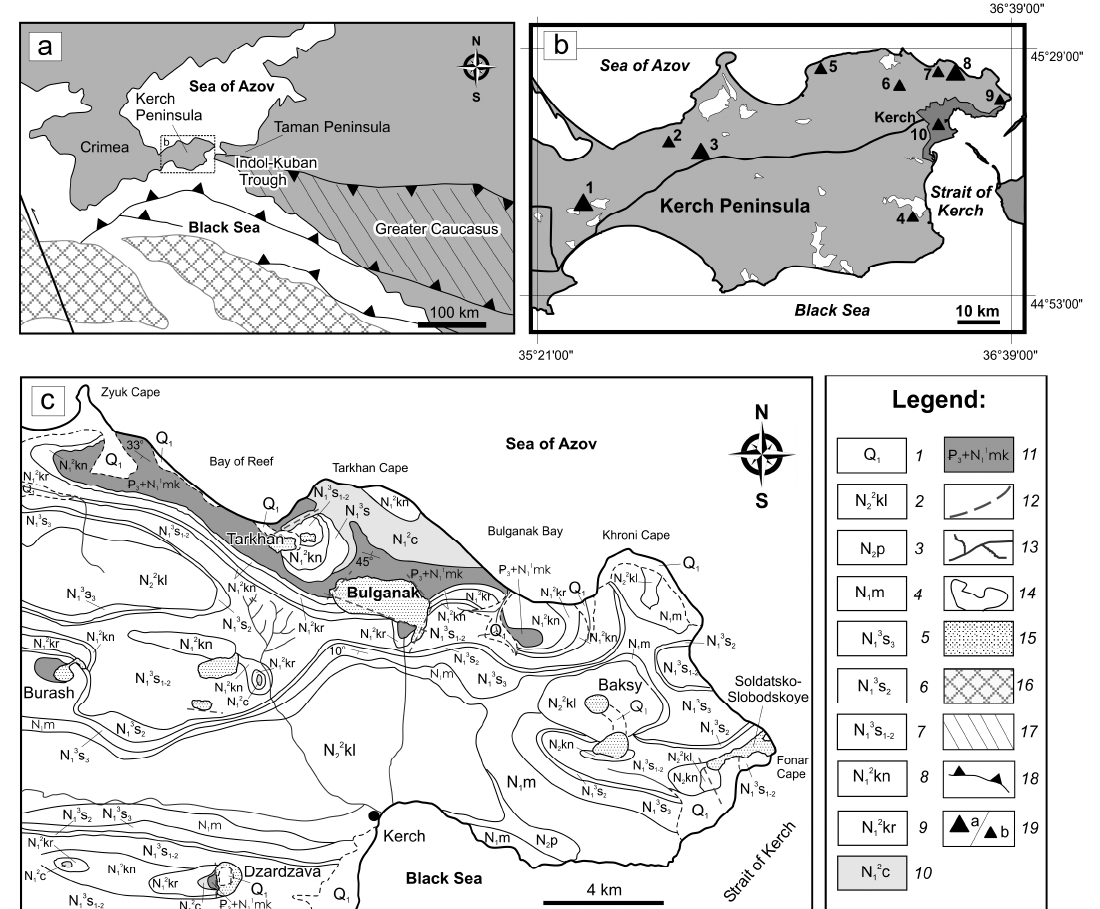
Figure 1. ( a ) Sketch map of the northeastern Black Sea region. Modified after [2]; ( b ) Location map of sampled mud volcanoes in the Kerch-Taman MV province. Modified after [3]. Grey colour–onshore area; white colour–offshore area. Mud volcanoes: Vladislavovsky (1), Nasyr (2), Korolevsky (3), Tobichek (4), Suyurtash (5), Burash (6), Big Tarkhan (7), Bulganak field (8), Eny–Kale (9), Soldatsko–Slobodsky (10); ( c ) Detailed geological map showing locations of mud volcanoes, geological structures and their sedimentary stratigraphy in the northeastern Kerch Peninsula. Modified after [59]. 1—Lower Quaternary sand, clay silt, and clay (Q 1 ); 2—Middle Pliocene sand, clay, and iron ore (Kuyalnik stage N 22 kl); 3—Lower Pliocene (Pontic stage N 2 p) shelly limestone, and clay; 4—Upper Miocene shelly limestone, reefal limestone with bryozoa, and clay (Meotic stage N 1 m); 5—Upper Miocene clay, marl, and limestone (Sarmat stage, upper substage N 13 s 3 ); 6—Upper Miocene clay, marl, limestone, and sand (Sarmat stage, middle substage N 13 s 2 ); 7—Upper Miocene clay with sand, marl, and shelly limestone interbeds (Sarmat stage, lower and middle substage N 13 s 1–2 ); 8—Middle Miocene organic limestone, gypsum, and clay with marl and sand interbeds (Konk stage N 12 kn); 9—Middle Miocene organic limestone, gypsum, and clay with marl and sand interbeds (Karagan stage N 12 kr); 10—Middle Miocene organic limestone, gypsum, and clay with marl and sand interbeds (Chokrak stage N 12 c); limestone aquifers; 11—Oligocene and Lower Miocene shale and silt (Maykop Formation P 3 + N 11 mk); 12—faults, 13—rivers, 14—stratigraphic boundaries; 15—mud volcanic field; 16—oceanic crust; 17—Alpine orogens; 18—Post-Eocene thrust; 19—a–large MV domes, b–small MV